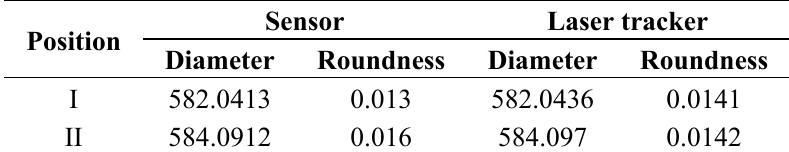
Table 2. Results measured in the laboratory (mm).